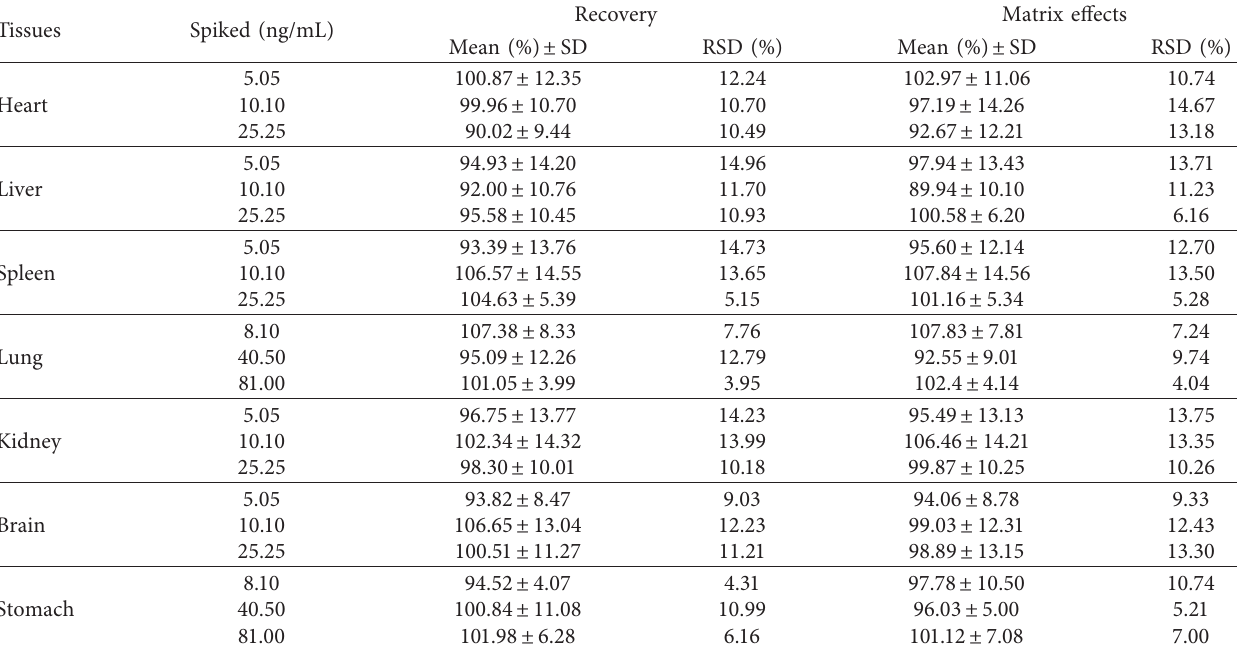
Table 11: Recovery and matrix effect study of luteolin-7- O-β -D-glucoside in rat tissues ( n � 6).